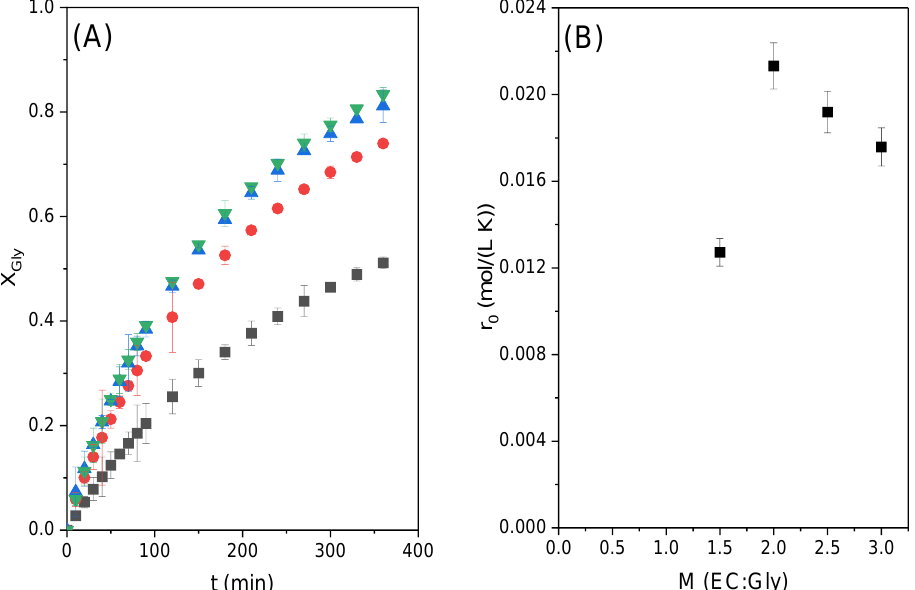
0 . 0 0100200300400